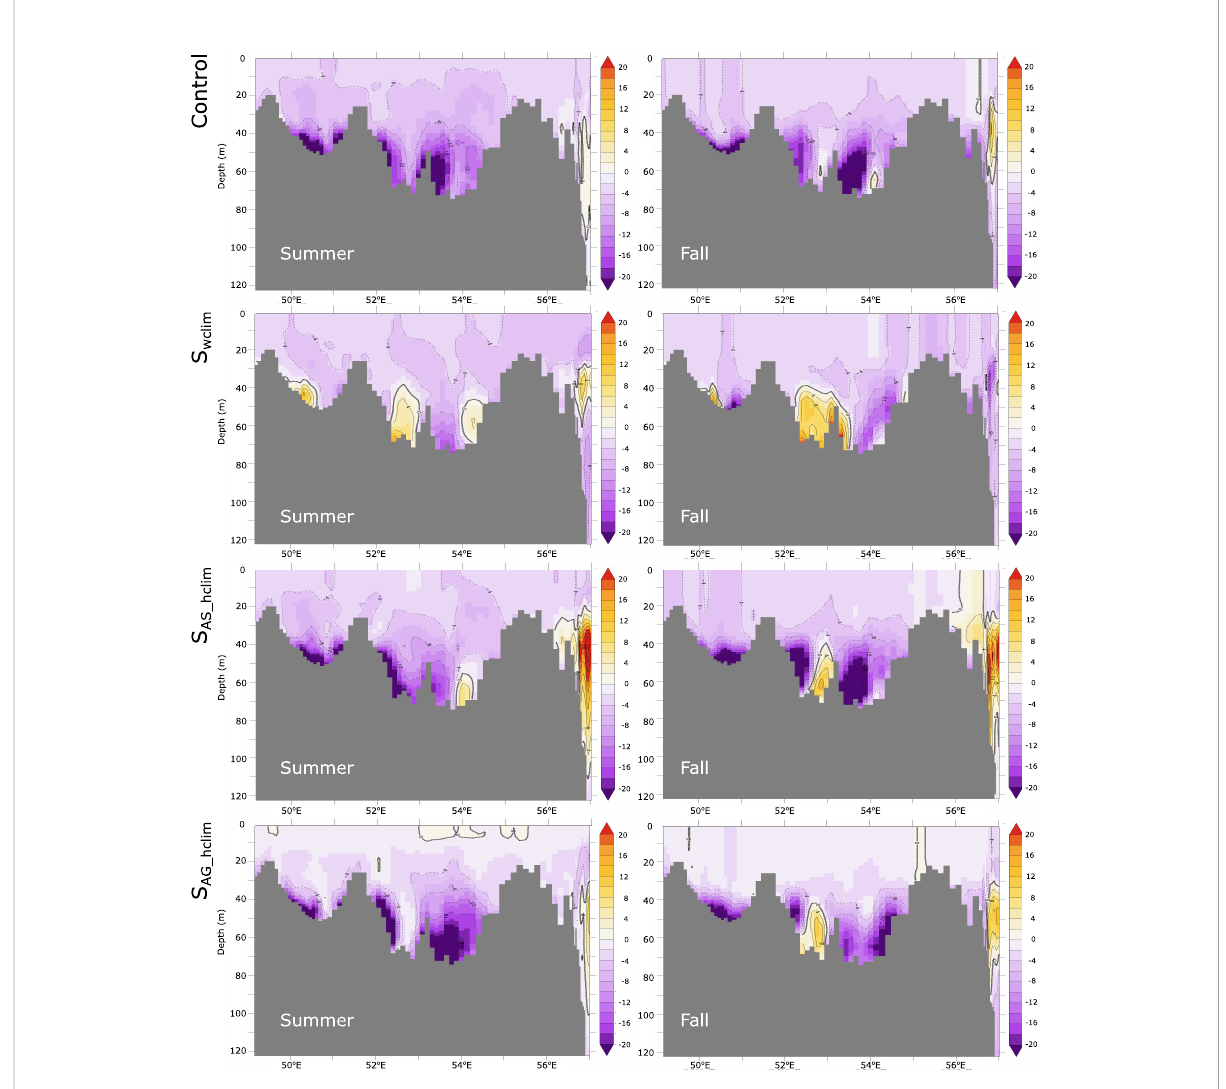
FIGURE 11 O 2 changes along the Gulf axis in the control and under different atmospheric forcing scenarios. O 2 changes between the early 1980s and the late 2000s along the Gulf axis (shown in Figure S1) in summer (left) and autumn (right) as simulated in the control (top), in absence of wind changes (i.e., S wclim ) (row 2), in absence of warming over the Arabian Sea (i.e., S AS_hclim ) (row 3) and in absence of Gulf warming (i.e., S AG_hclim )